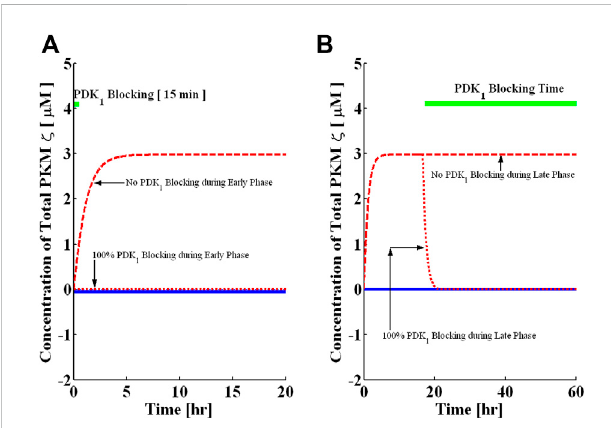
FIGURE 5 Blocking the PDK1 activity in the early and late phases. Simulations are implemented with and without protein synthesis pulse U. A brief pulse of protein synthesis is used to mimic the induction of L-LTP by applying a high-frequency stimulus. The solid blue line represents PKM ζ , the concentration at basal levels of protein synthesis (without the application of pulse), and the dashed red line represents the PKM ζ concentration with the application of a protein synthesis pulse. (A) PDK 1 activity blocking during induction for 15 min (solid green line shows blocking time). Complete blocking of activity during the early phase completely abolishes the induction phase of L-LTP. (B) PDK1 activity blocking during maintenance for 90 h (solid green line shows blocking time). The complete activity blocking during maintenance reverses the established L-LTP from the up to the down state.